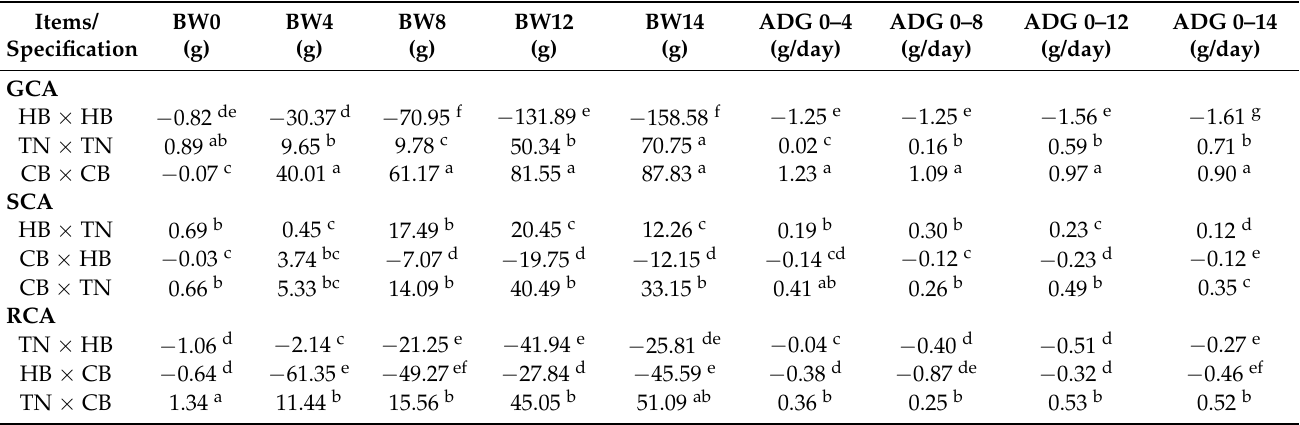
Table 2. The combining ability for body weight and average daily gain of black-bone chickens, Thai native chickens, and their